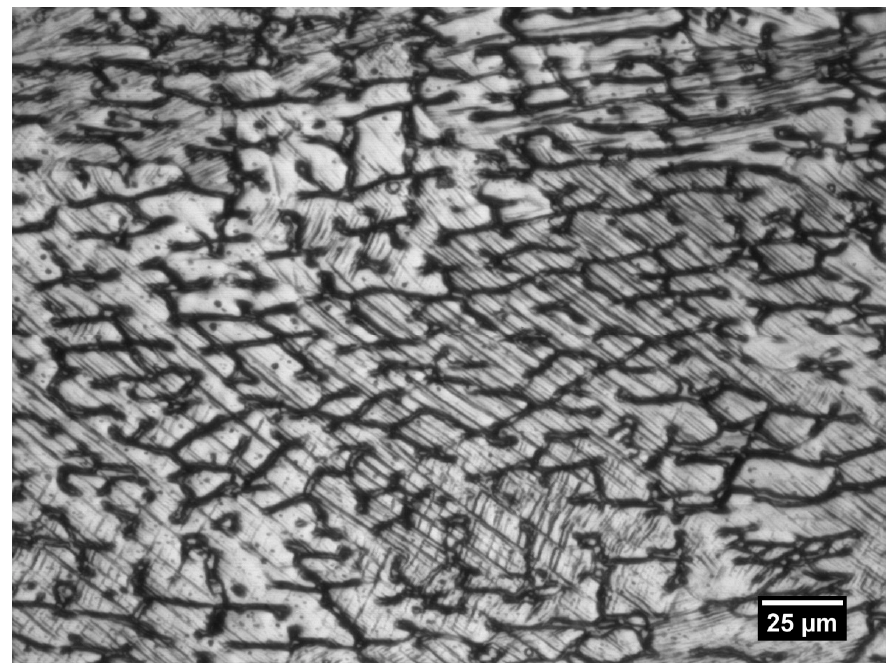
Figure 8. Deformation twins in one of the 33% cold rolled samples. Martensite grows along the deformation twin boundaries.